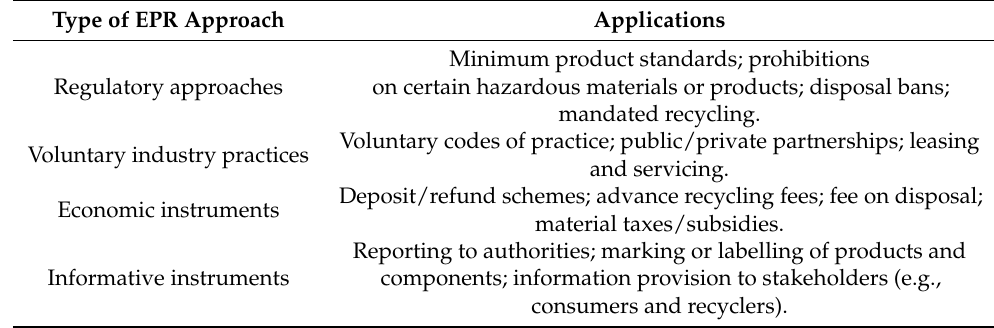
Table 3. Extended producer responsibility (EPR) policy instruments